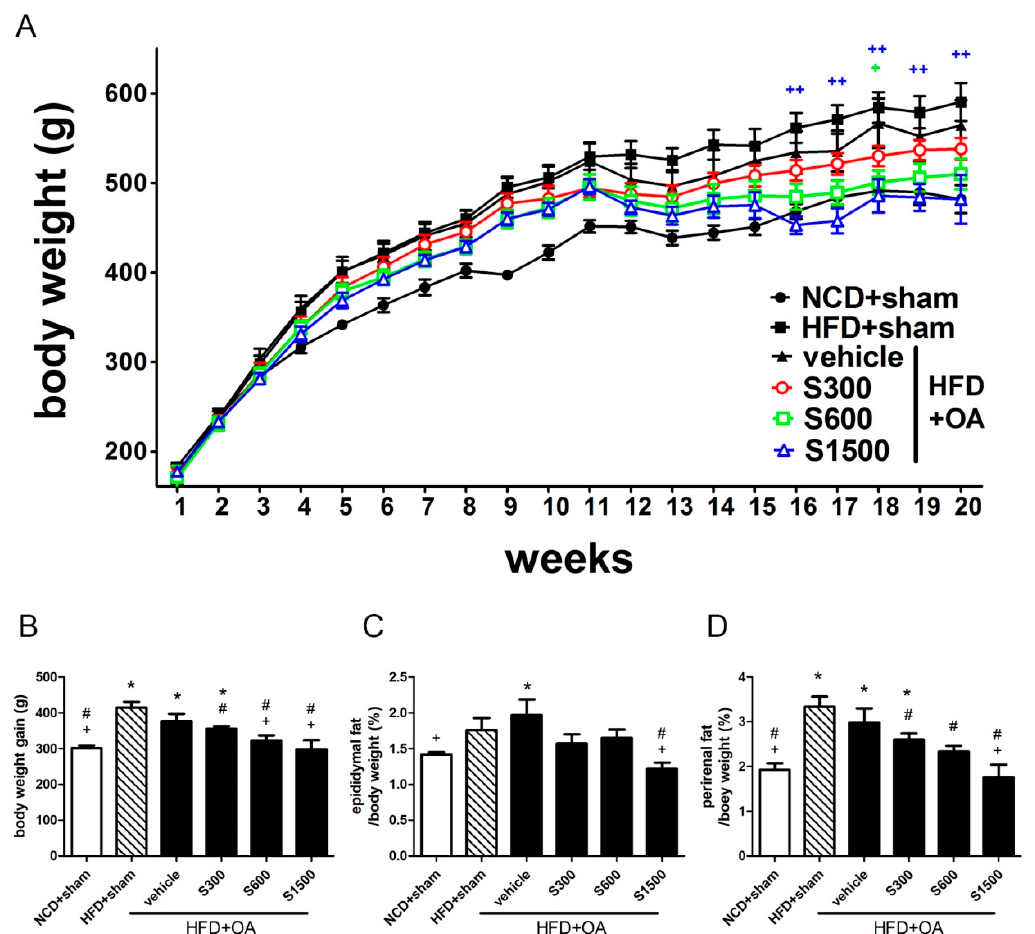
Figure 2. Effects of Shiikuwasha Extract (SE) on body weight and fat pad weight. ( A ) Body weight during the experiment, ( B ) body weight gain obtained from the difference between the body weights at the 1st week and 20th week, ( C ) epididymal fat weight, and ( D ) perirenal fat weight in the NCD+Sham, HFD+Sham, vehicle, S300, S600, and S1500 groups. Values are expressed as means ± S.E.M ( n = 6). + p < 0.05 and ++ p < 0.01 when compared to the vehicle group using two-way ANOVA and Dunnett’s multiple comparisons test in Figure 2A. * p < 0.05 when compared to the NCD+sham group; # p < 0.05 when compared to the HFD+sham group; + p < 0.05 when compared to the vehicle group. The letters were calculated by one-way ANOVA and Duncan’s multiple range test in Figure 2B, Figure 2C and Figure 2D.